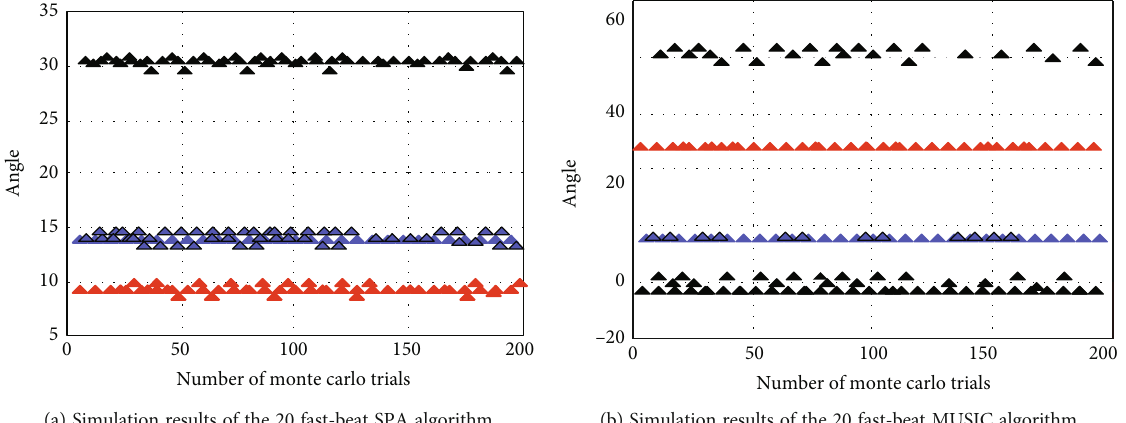
Figure 5: Comparison of DOA results of 20